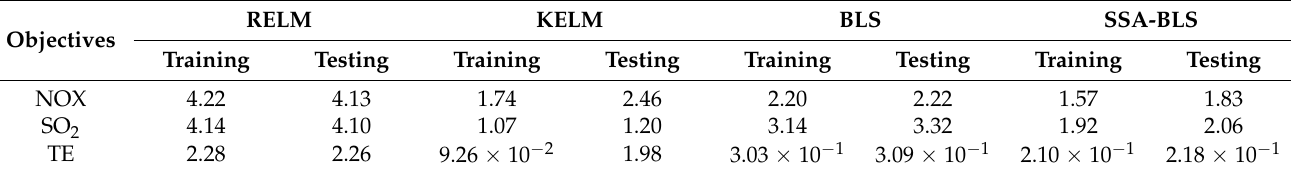
Table 11. The MAPE of the four algorithms on the training set and testing set of boiler